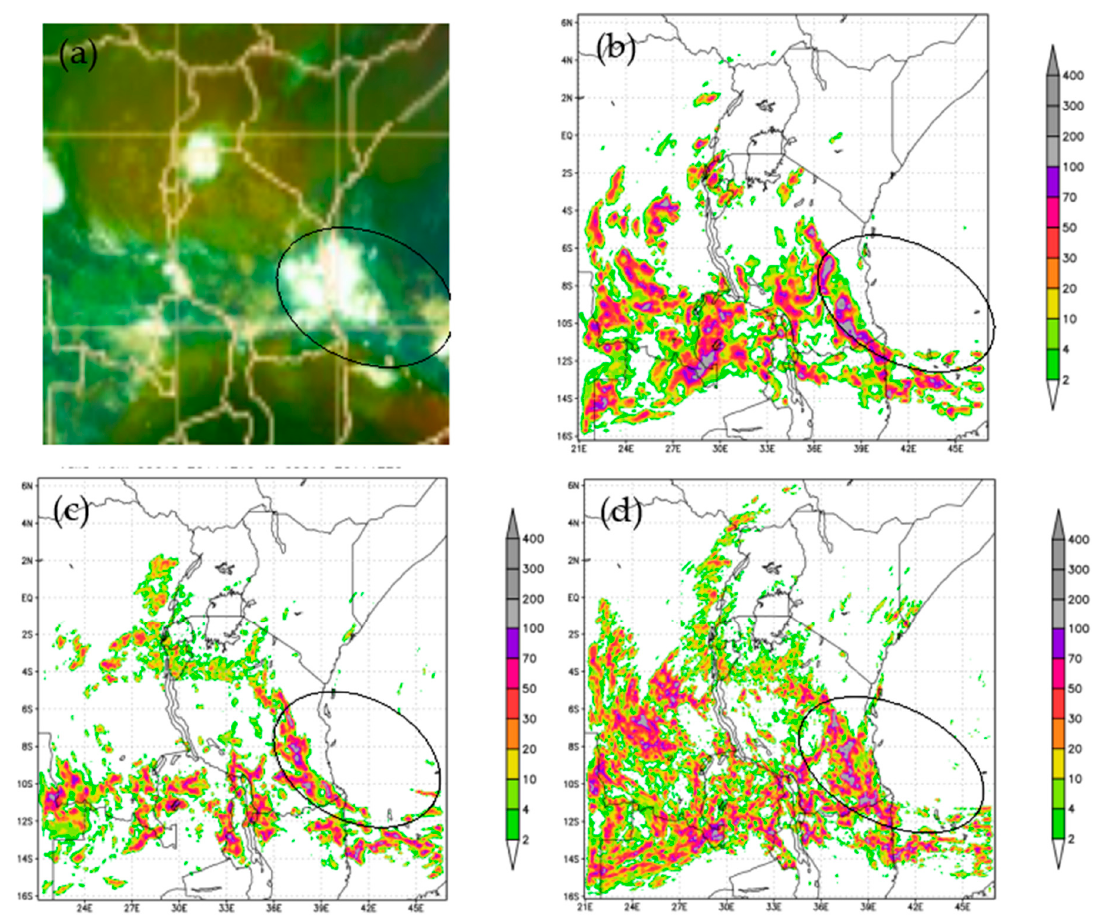
Figure 8. Total precipitation amount during the wet season on 20 December 2011. ( a ) Satellite observation from airmass RGB (WV6.2–WV7.3, IR9.7–IR10.8, WV6.2) image source: EUMETSAT; and 24-h accumulated model rainfall forecasts for ( b ) 15 / 5 km resolution; ( c ) 12 / 4 km resolution; ( d ) 9 / 3 km resolution. Colorbars represent the total precipitation amount (mm).